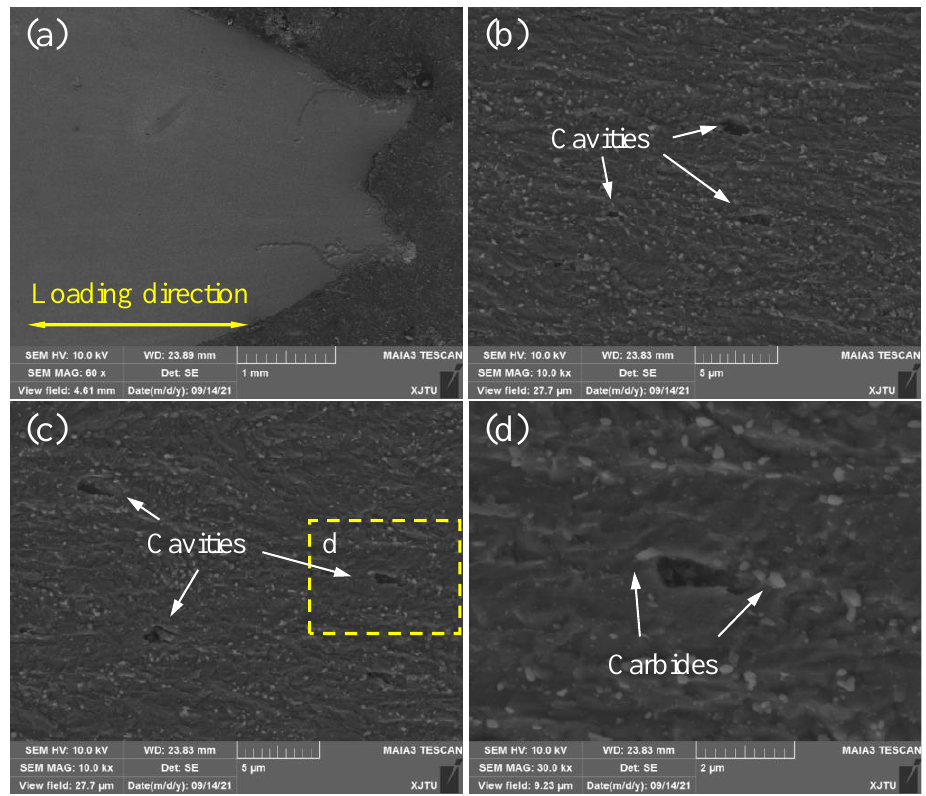
Figure 9. SEM images of the main damage zone of creep-ruptured BM specimen at 550 °C. ( a ) The overall micrograph of the longitudinal cross-section; ( b , c ) are the distribution of creep cavities; ( d ) is the magnified graph of corresponding creep cavities in ( c ).